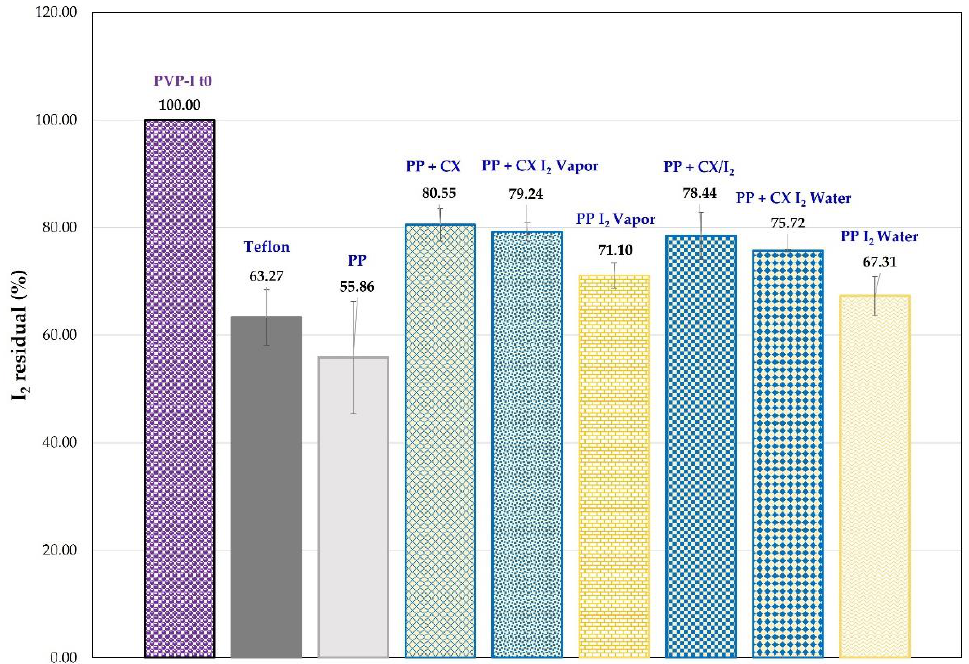
Figure 12. Residual iodine (%) determined in PVP-I buffered solution after 7 days at 40 °C in vials closed with cups of PP samples, unmodified and embedded with CX and its complex and I 2 .